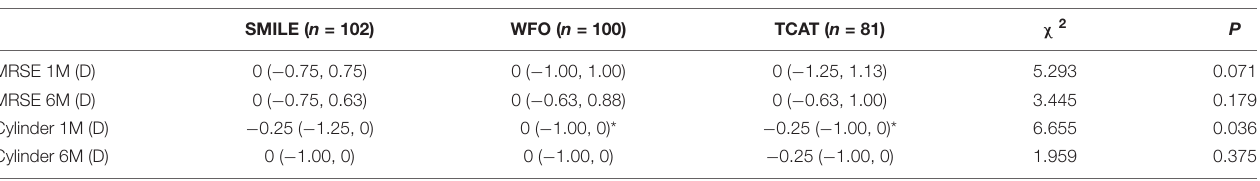
FIGURE 2 | Change in Snellen lines of corrected distance visual acuity at postoperative 6-month. (A) SMILE group, (B) wavefront optimized group, (C) topography-guided custom ablation treatment group. TABLE 2 | Comparison of postoperative manifest refraction among the three